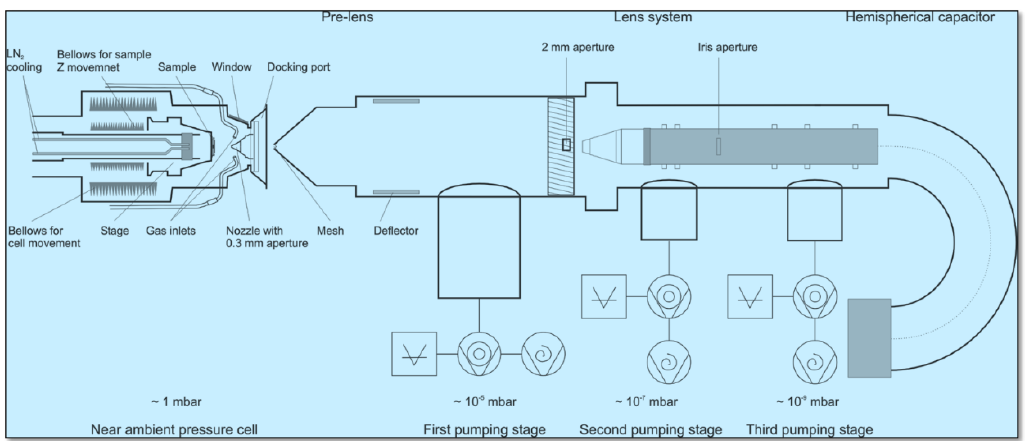
Figure 5. A schematic of the NAP-XPS system utilized for high temperature up to 400 °C and high pressure CO and O 2 exposures and simultaneous X-ray photoelectron spectroscopy (XPS) data collection.